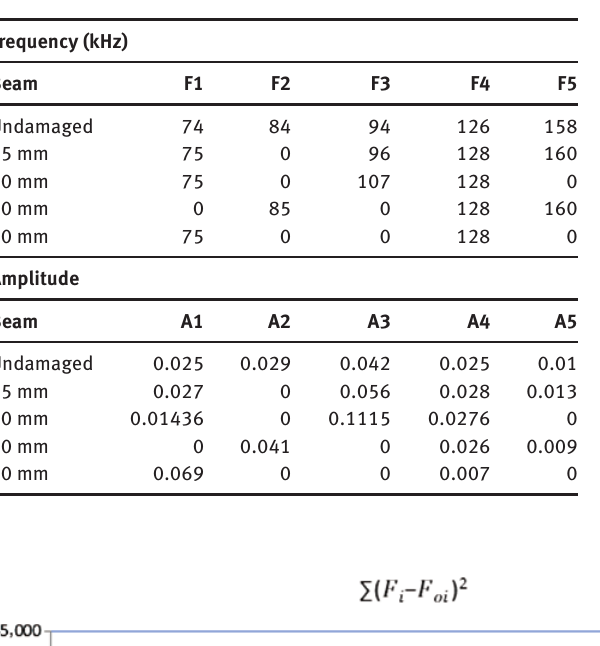
Table 3: Section 1 frequencies and amplitudes.